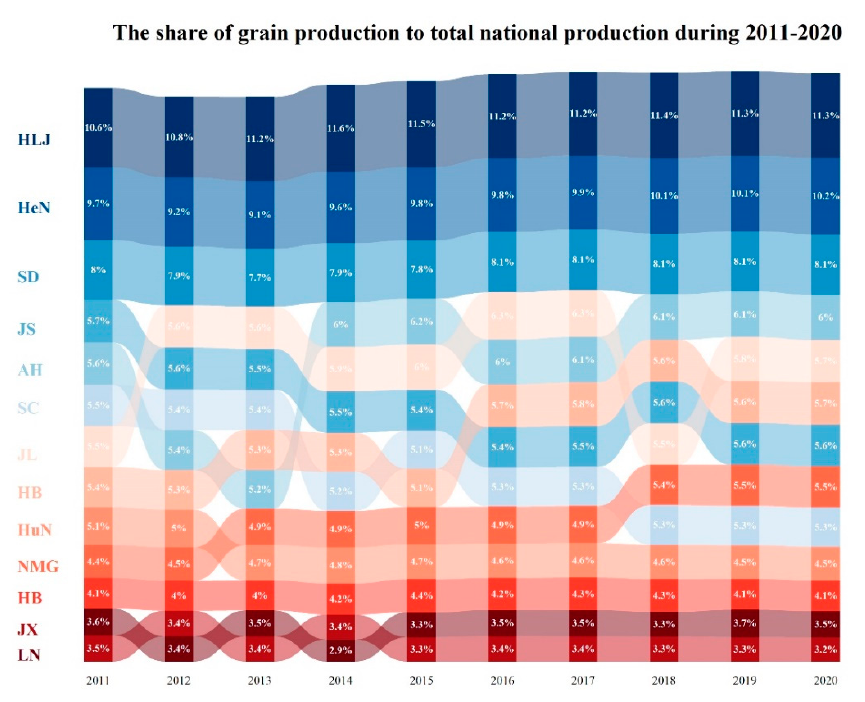
Table 2. The non-grain ratios of China during 2011–2020.